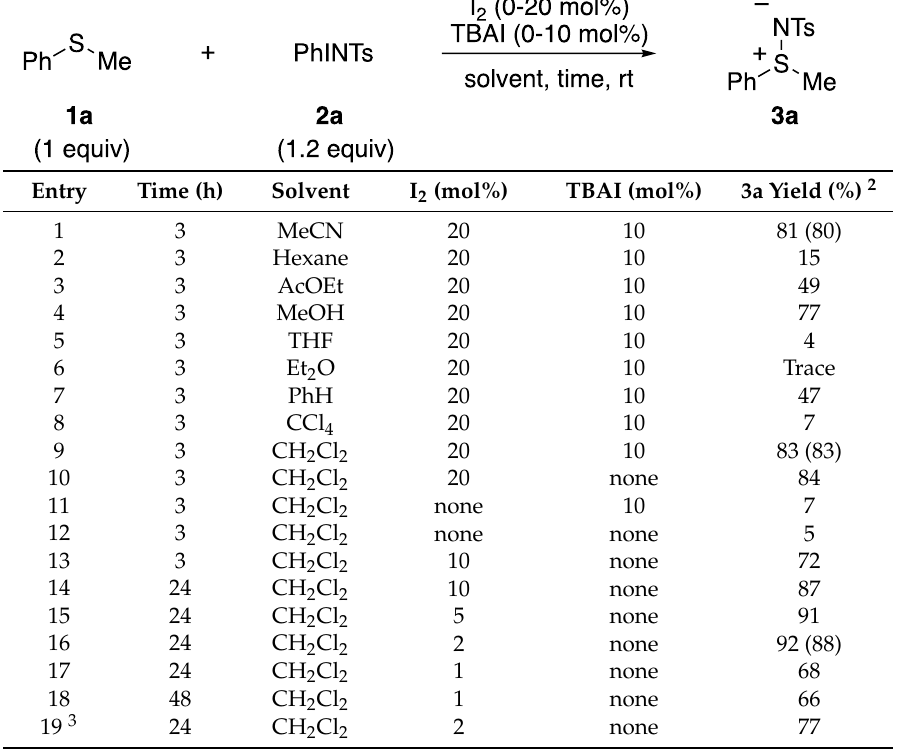
Table 1. Optimization of imination reaction of thioanisole 1a using ( N -tosylimino)-phenyl- λ 3 -iodane 2a 1 .